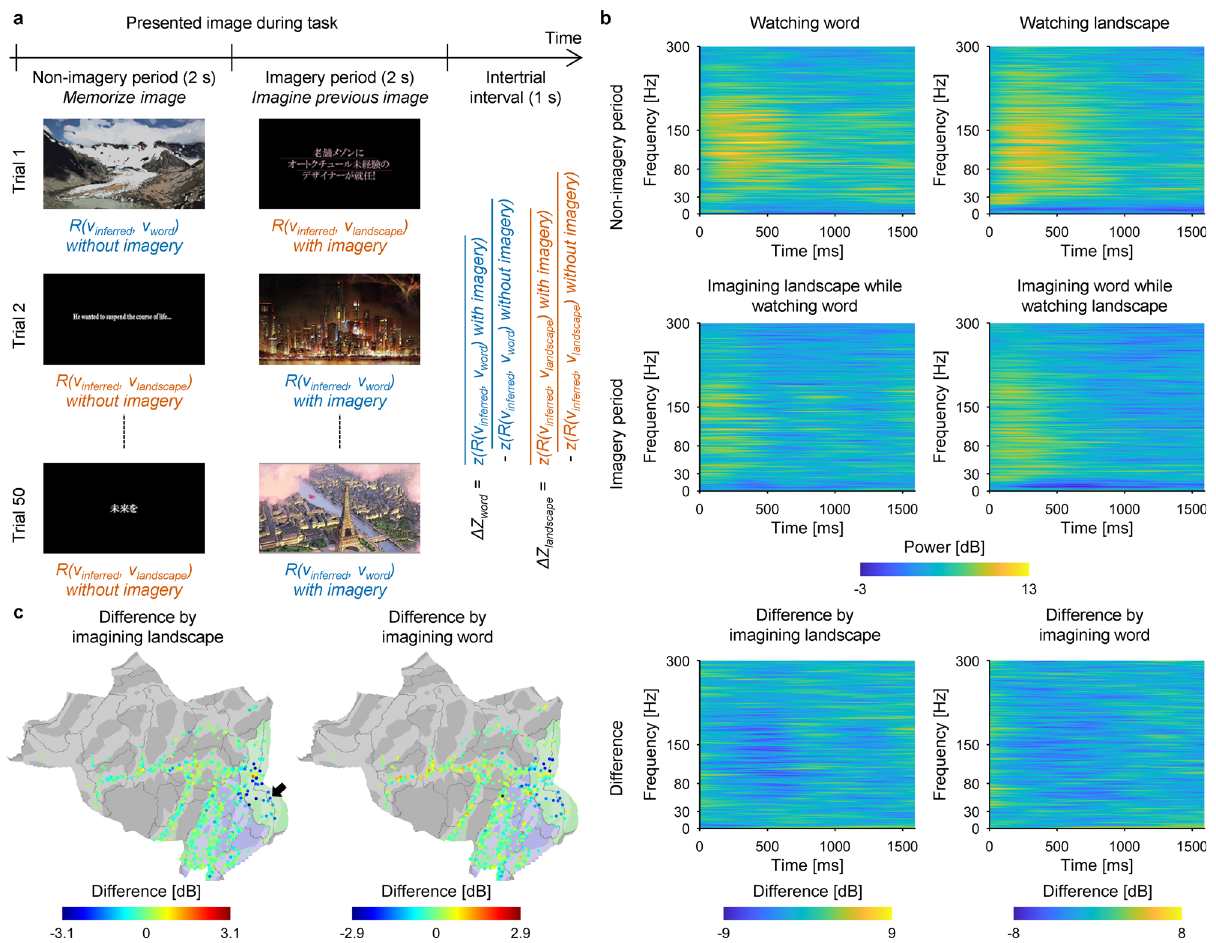
Fig. 6 ECoGs during the imagery task. a Schematic of the imagery task. After the presentation of the word or landscape image (nonimagery period), the subjects imagined the word image during the presentation of the landscape image, or imagined the landscape image during the presentation of the word image (imagery period). For all combinations of images, the trials were repeated in randomized order, resulting in 50 trials. To obtain modulation of R ( v inferred , v word ) due to imagining the word image ( Δ Z word ), the R ( v inferred , v word ) during the presentations of landscape images were Fisher z-transformed and averaged within the nonimagery period and the imagery period to calculate the difference between them ( z ð R ð v inferred ; v word ÞÞ during imagery period – z ð R ð v inferred ; v word ÞÞ during nonimagery period). Similarly, Δ Z landscape was evaluated from the R ( v inferred , v landscape ) during the presentation of word images. b Results of time – frequency decomposition for the ECoGs of the electrode indicated by the black arrow in ( c ). The upper and middle panels represent the time – frequency maps of ECoGs while watching the image of words (left) and landscapes (right) during the nonimagery period and imagery period, respectively. The difference between these two maps of each column is shown in the bottom panel. c Powers in the high- γ band from 0 to 1 s after the presentation of word images (left) and landscape images (right) were subtracted between the two periods (imagery period – nonimagery period) to be shown on the cortical surface at the location of each subdural electrode with